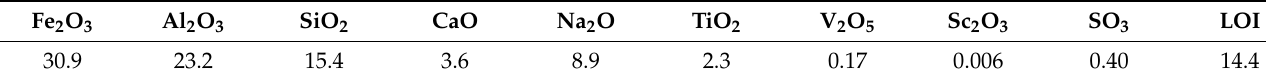
Table 1. Composition of red mud based on XRF analysis (wt.%).